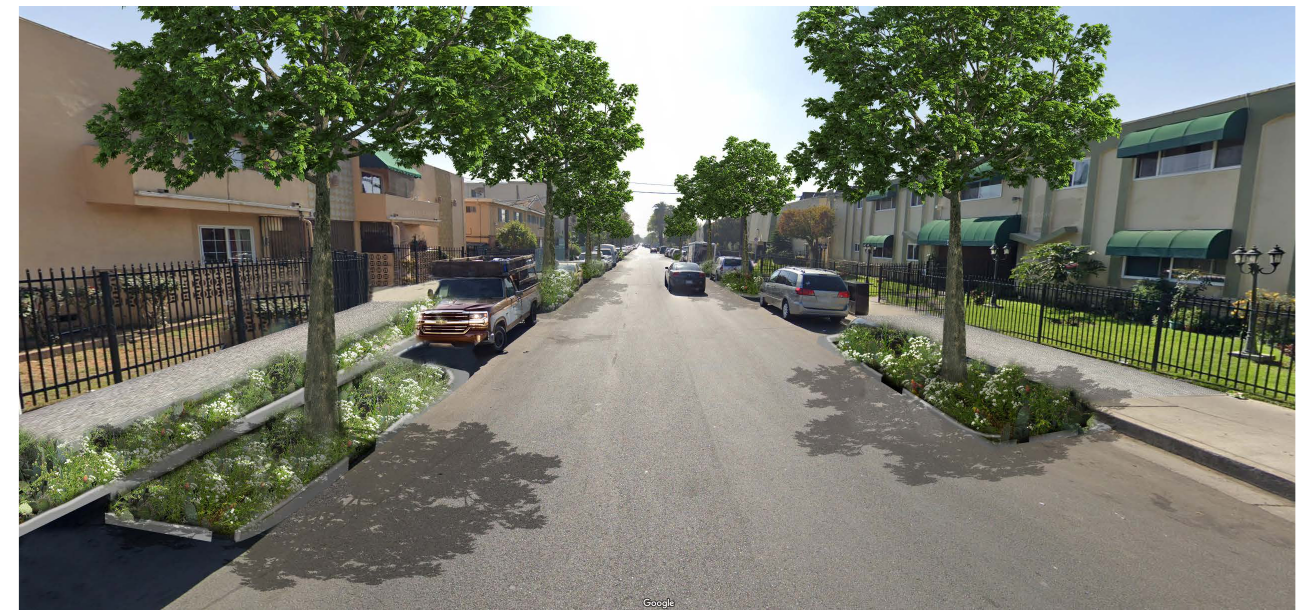
Figure 12. Panorama City MPTs’